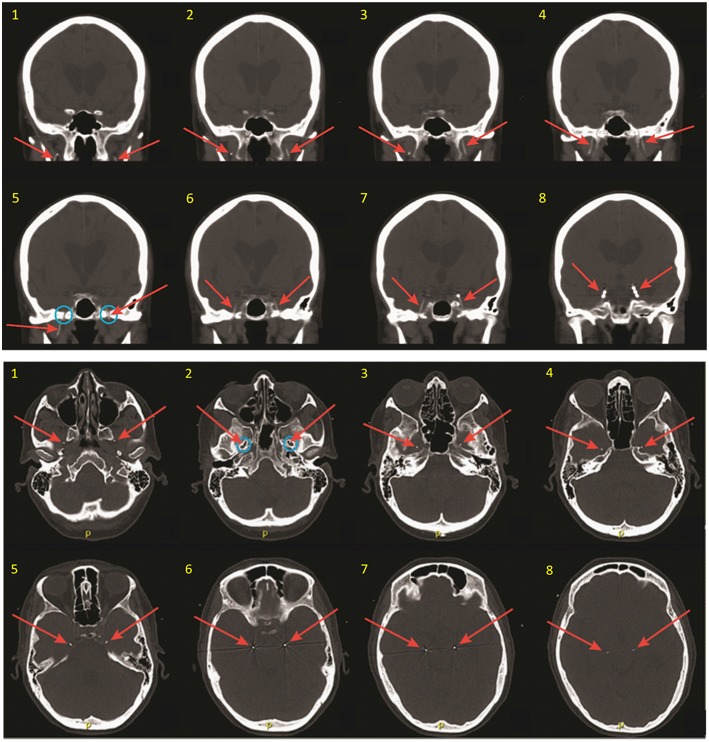
Coronal (top) and thin axial (bottom) views on post-operative CT scan, demonstrating FO electrode positioning. Slices are numbered in ascending order from anterior to posterior (coronal images), and from inferior to superior (axial images). Red arrows show the FO electrodes in each image. Note that the FO electrodes are only 1 mm in diameter but appear larger in these images due to image slice thickness and windowing needed for visualization. Blue circles show the foramen ovale.